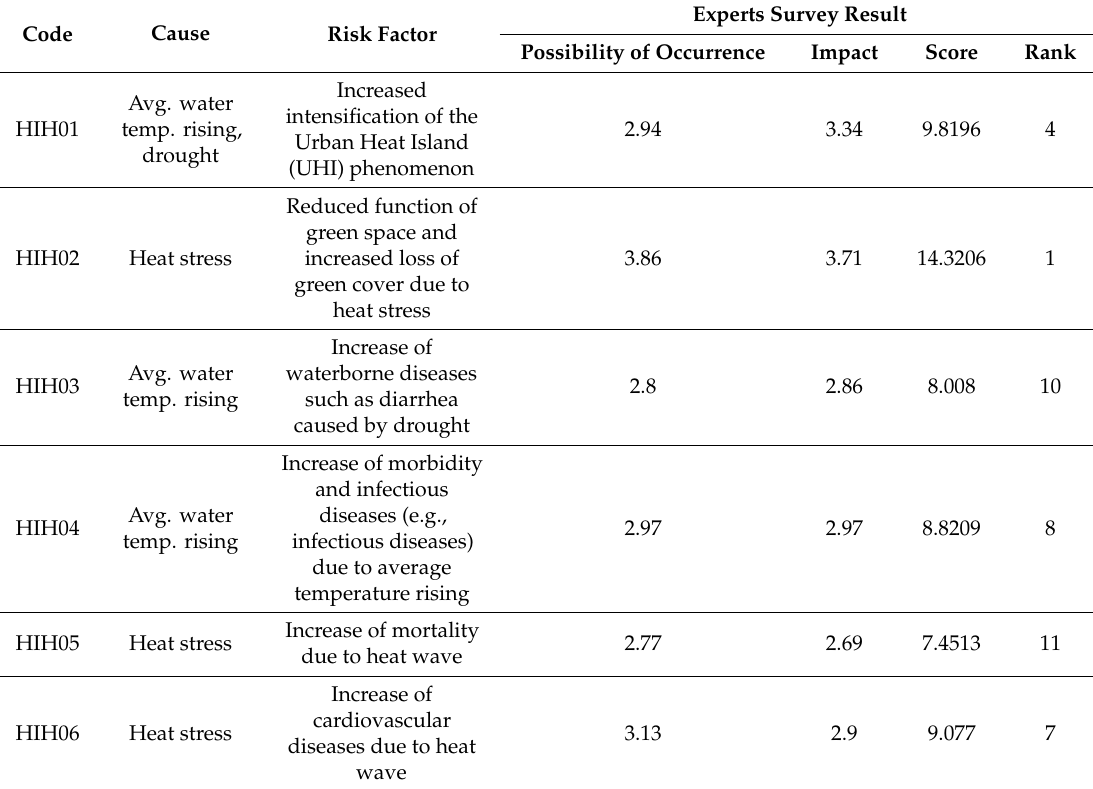
Table A7. HIH risk factors and assessment result of